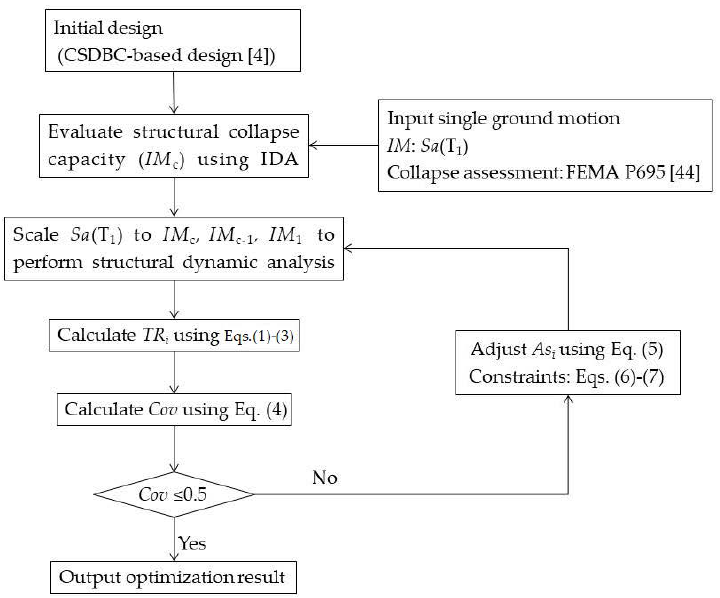
Figure 2. Flowchart of the proposed optimization method.